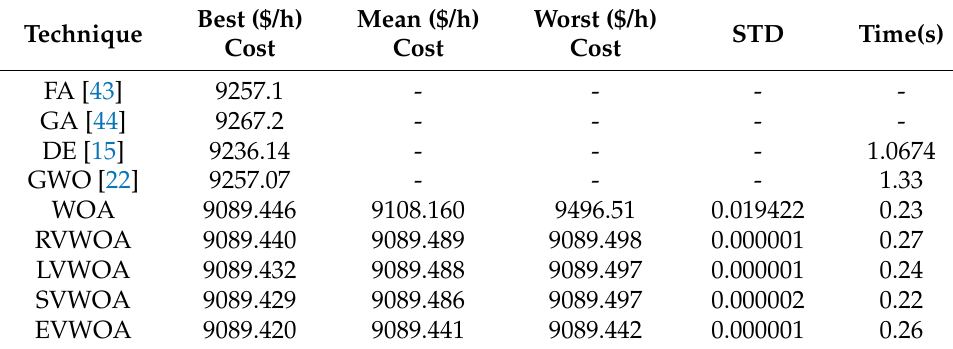
Table 5. Comparison of quality solution for Case Study